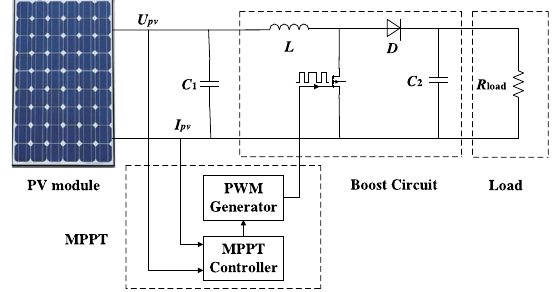
Fig. 4 PV system structure with MPPT control in